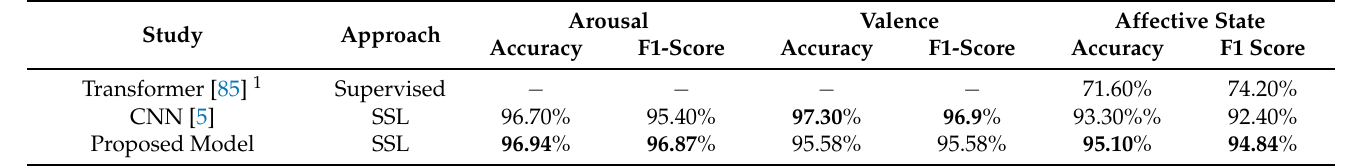
Table 9. Classification results reported by various state-of-the-art works on the SWELL